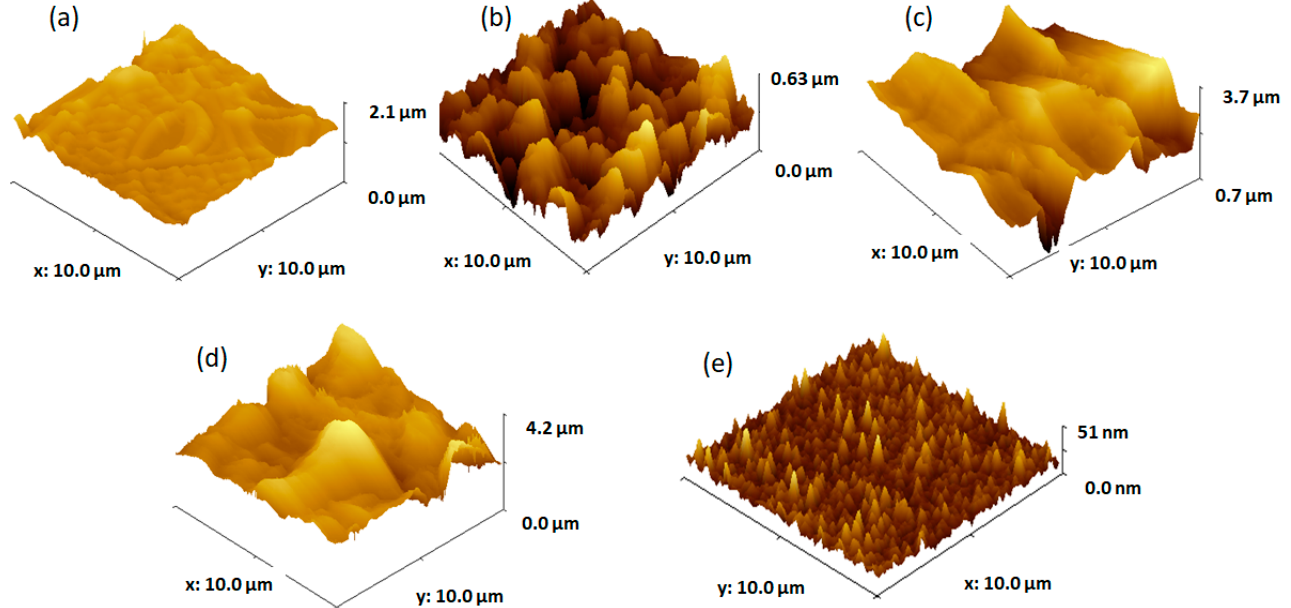
Figure 2. AFM images of TiO 2 films obtained from solution 1 by ( a ) two dip-coating cycles, ( b ) four dip-coating cycles, ( c ) six dip-coating cycles, ( d ) eight dip-coating cycles, and ( e ) FTO substrate. Table 1. The thickness and roughness of TiO 2